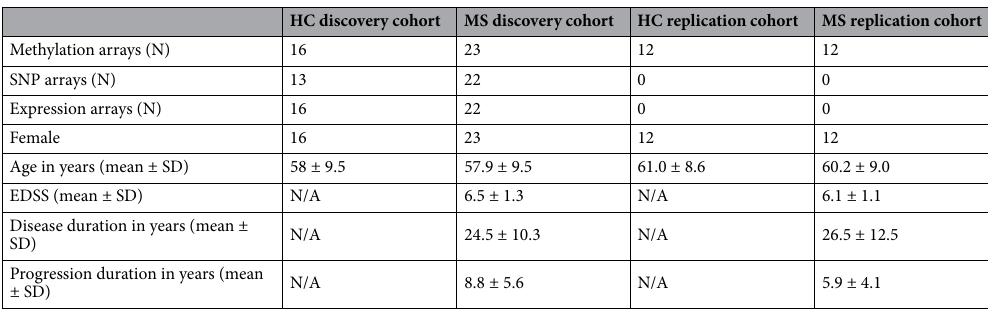
Table 1. Patient characteristics. SD standard deviation, HC healthy controls, EDSS expanded disability status score, N/A not